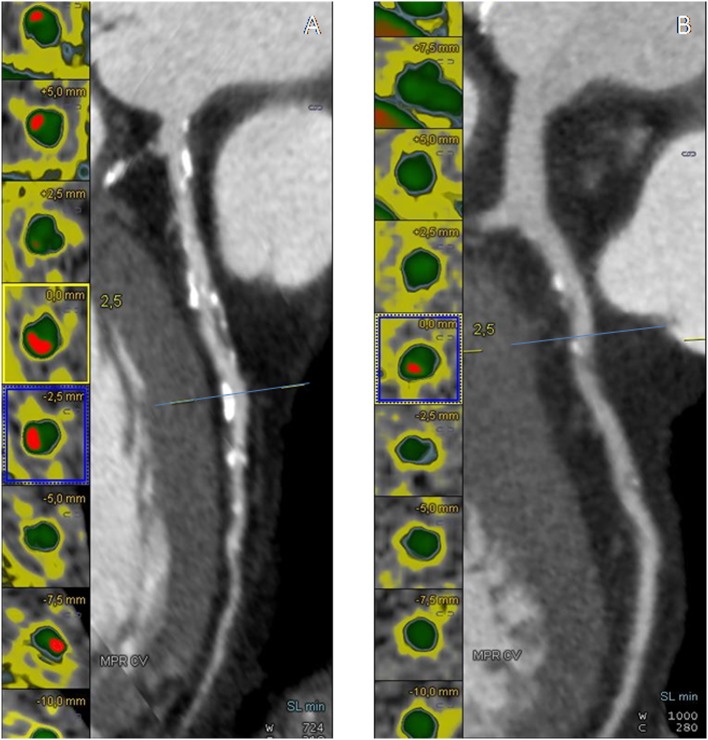
(A,B) Cross-sectional view and cMPR of the left descending coronary artery (LAD) in a non-diabetic CAD patient (DM−CAD+) and in a diabetic CAD patient (DM+CAD+). In cross-sectional images, the vessel lumen is represented in green whereas the calcific component of the plaque is red.